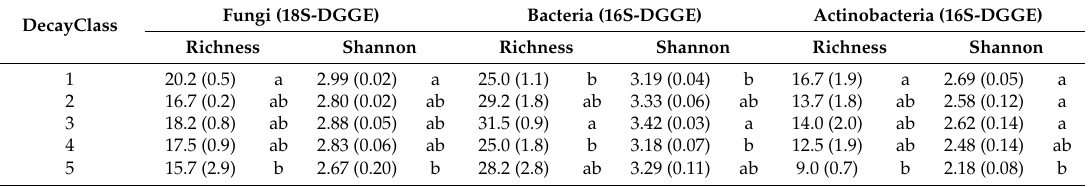
Table 2. Average species richness and Shannon-Weiner diversity index calculated on 18S- and 16S-DGGE band profiles from fungal, bacterial, and actinobacterial communities in black pine deadwood, on the basis of decay class; standard errors in